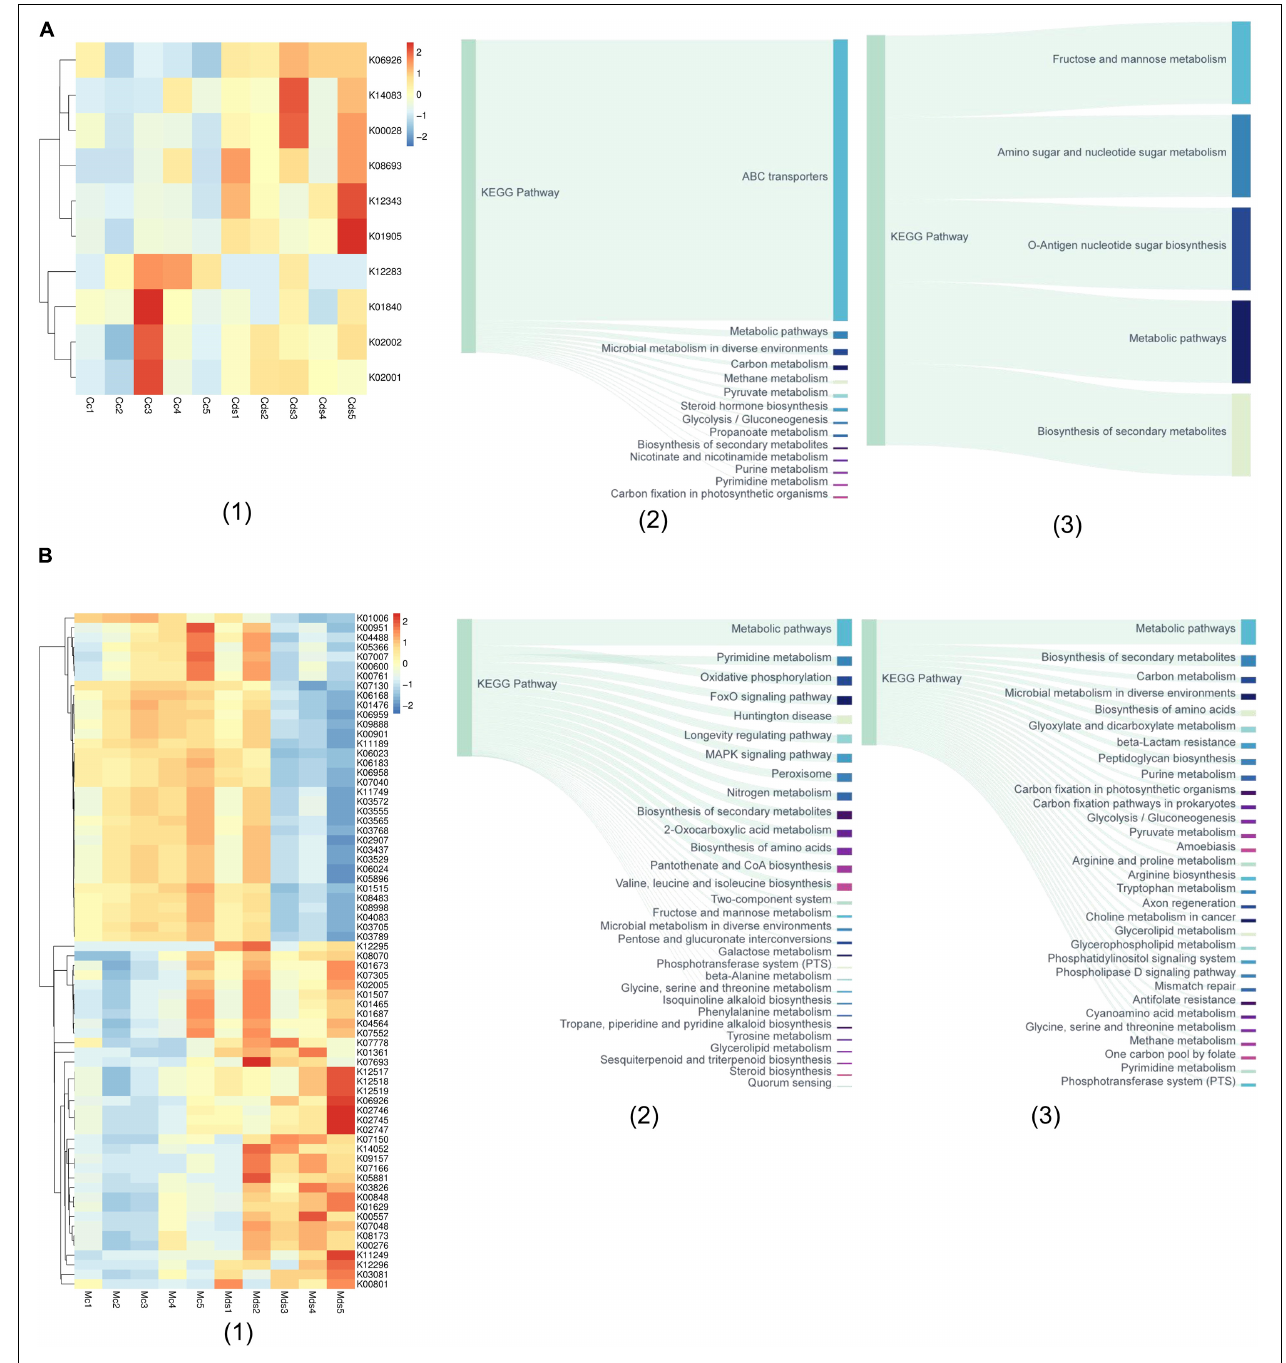
FIGURE 4 | The metagenomic function prediction of the pathway based on the KEGG database. (A) The main KEGG pathway analysis of bacterial genes in intestinal contents of repeated stress-related diarrhea mice. (1) The relative abundance of differentially expressed KOs in intestinal content microbiota of repeated stress-related diarrhea mice; (2) the main KEGG pathway of the KOs with significantly increased expression in intestinal contents of repeated stress-related diarrhea mice; (3) the main KEGG pathway of the KOs with significantly decreased expression in intestinal contents of repeated stress-related diarrhea mice. (B) KEGG pathway analysis of bacterial genes in intestinal mucosa of repeated stress-related diarrhea mice. (1) The relative abundance of differentially expressed KOs in intestinal mucosa microbiota of repeated stress-related diarrhea mice; (2) the main KEGG pathway of the KOs with significantly increased expression in intestinal mucosa of repeated stress-related diarrhea mice; (3) the main KEGG pathway of the KOs with significantly decreased expression in intestinal mucosa of repeated stress-related diarrhea mice. Cc, intestinal contents in control mice; Cds, intestinal contents in repeated stress-related diarrhea mice; Mc, intestinal mucosa in control mice; Mds, intestinal mucosa in repeated stress-related diarrhea